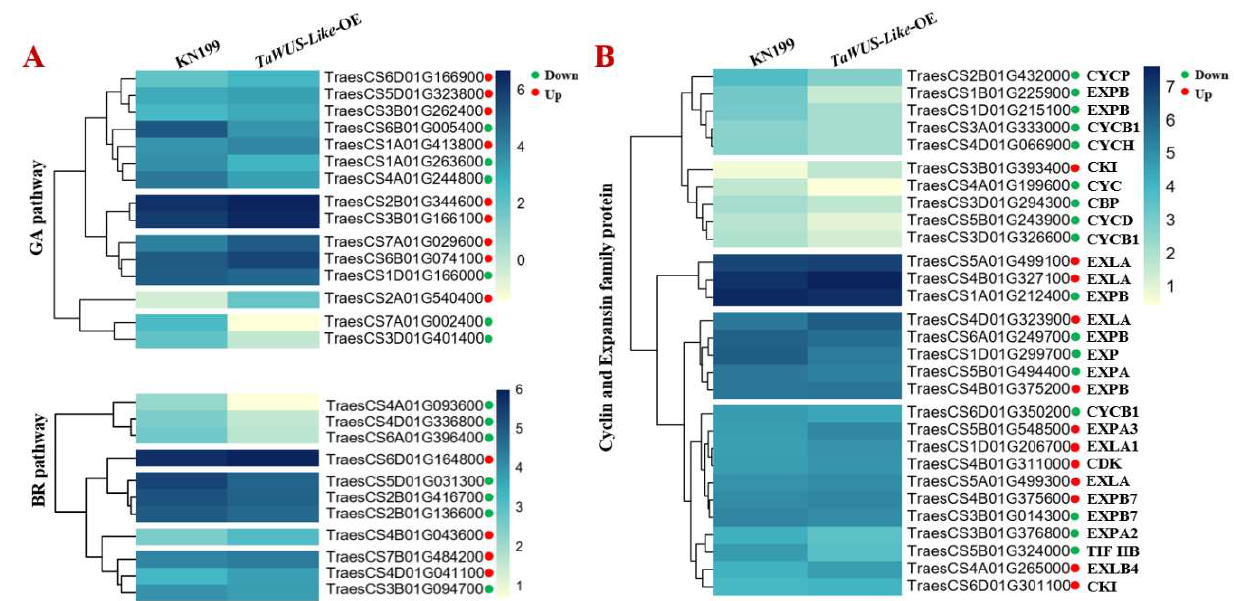
Figure 4. Expression levels of the downstream GA-, BR- ( A ) and cell division-related genes ( B ) regulated by TaWUS-like- OE. Red and green circles indicate the expression of the genes was changed upward and downward, respectively.